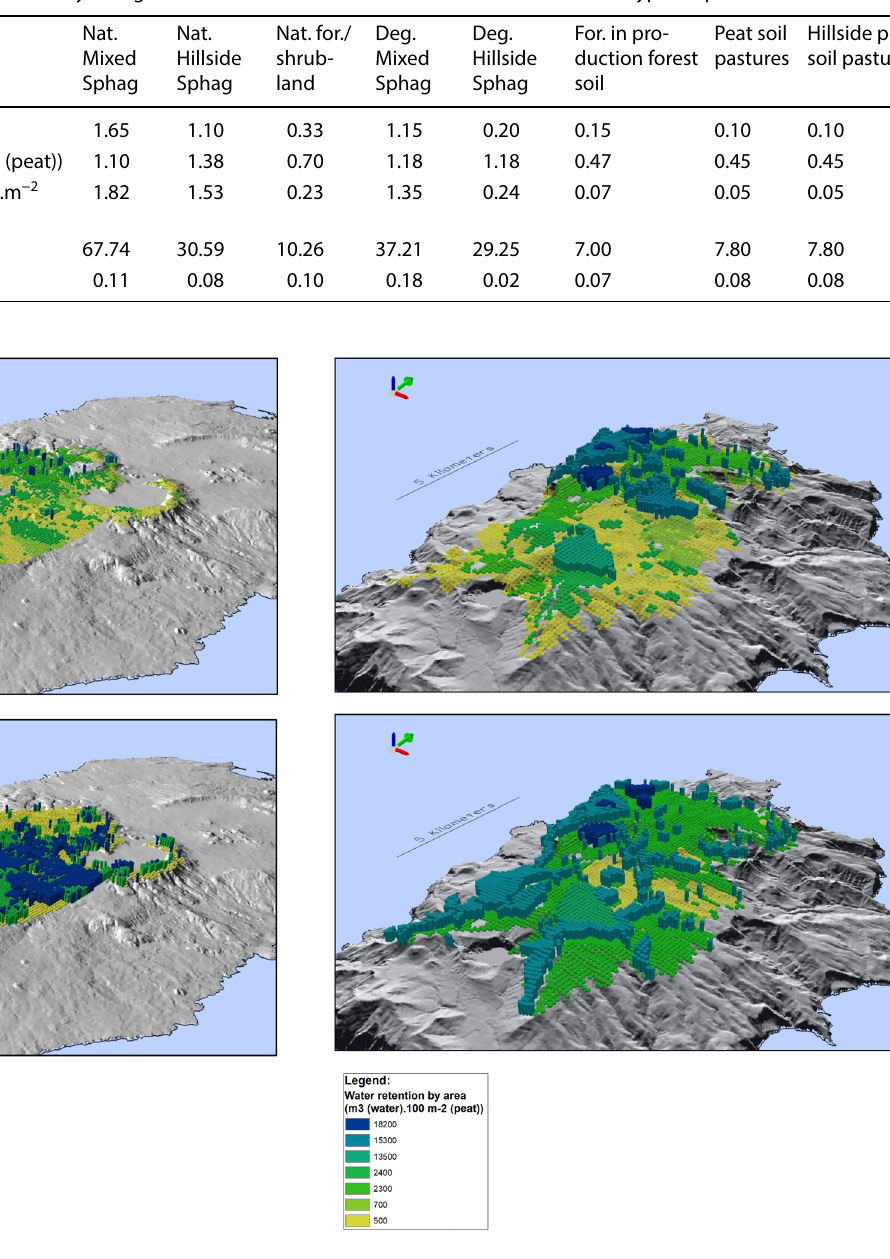
Table 3 Average values of peat depth and hydrological services indicators obtained for Terceira and Flores’ types of peatlands